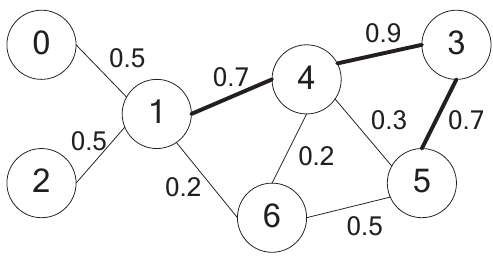
Figure 2. An example of an information diffusing probability